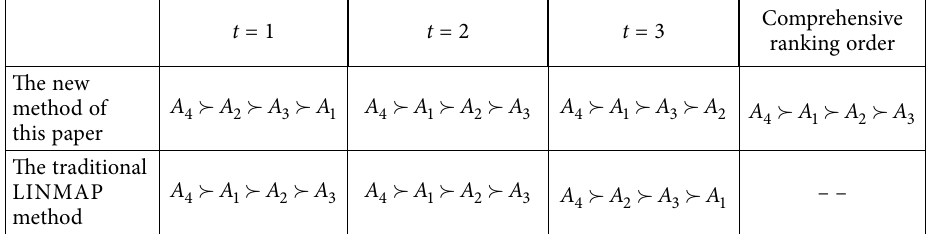
Comprehensive ranking